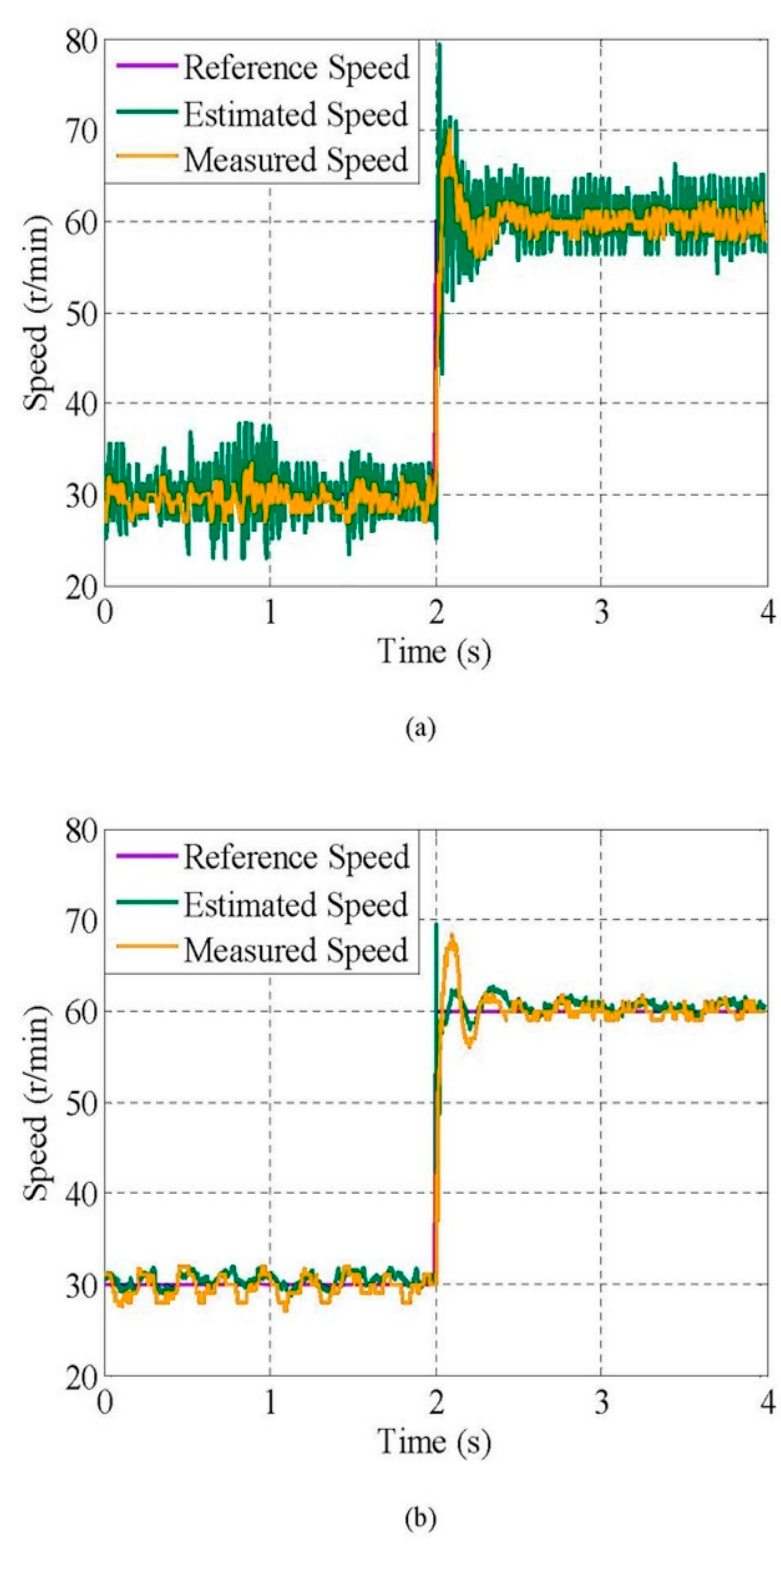
Figure 14. Speed-tracking performance under the reference speed change from 30 to 60 rpm at full load. ( a ) MRAS control method. ( b ) Proposed MPC-MRAS control method.